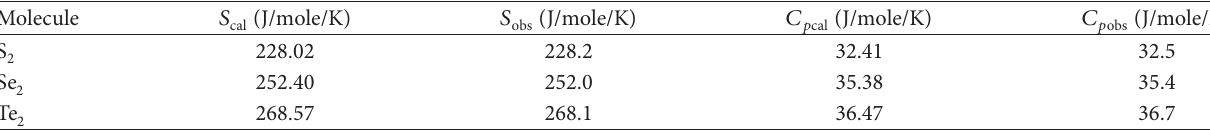
T 6: Comparison of calculated and observed thermodynamical quantities at 300K.